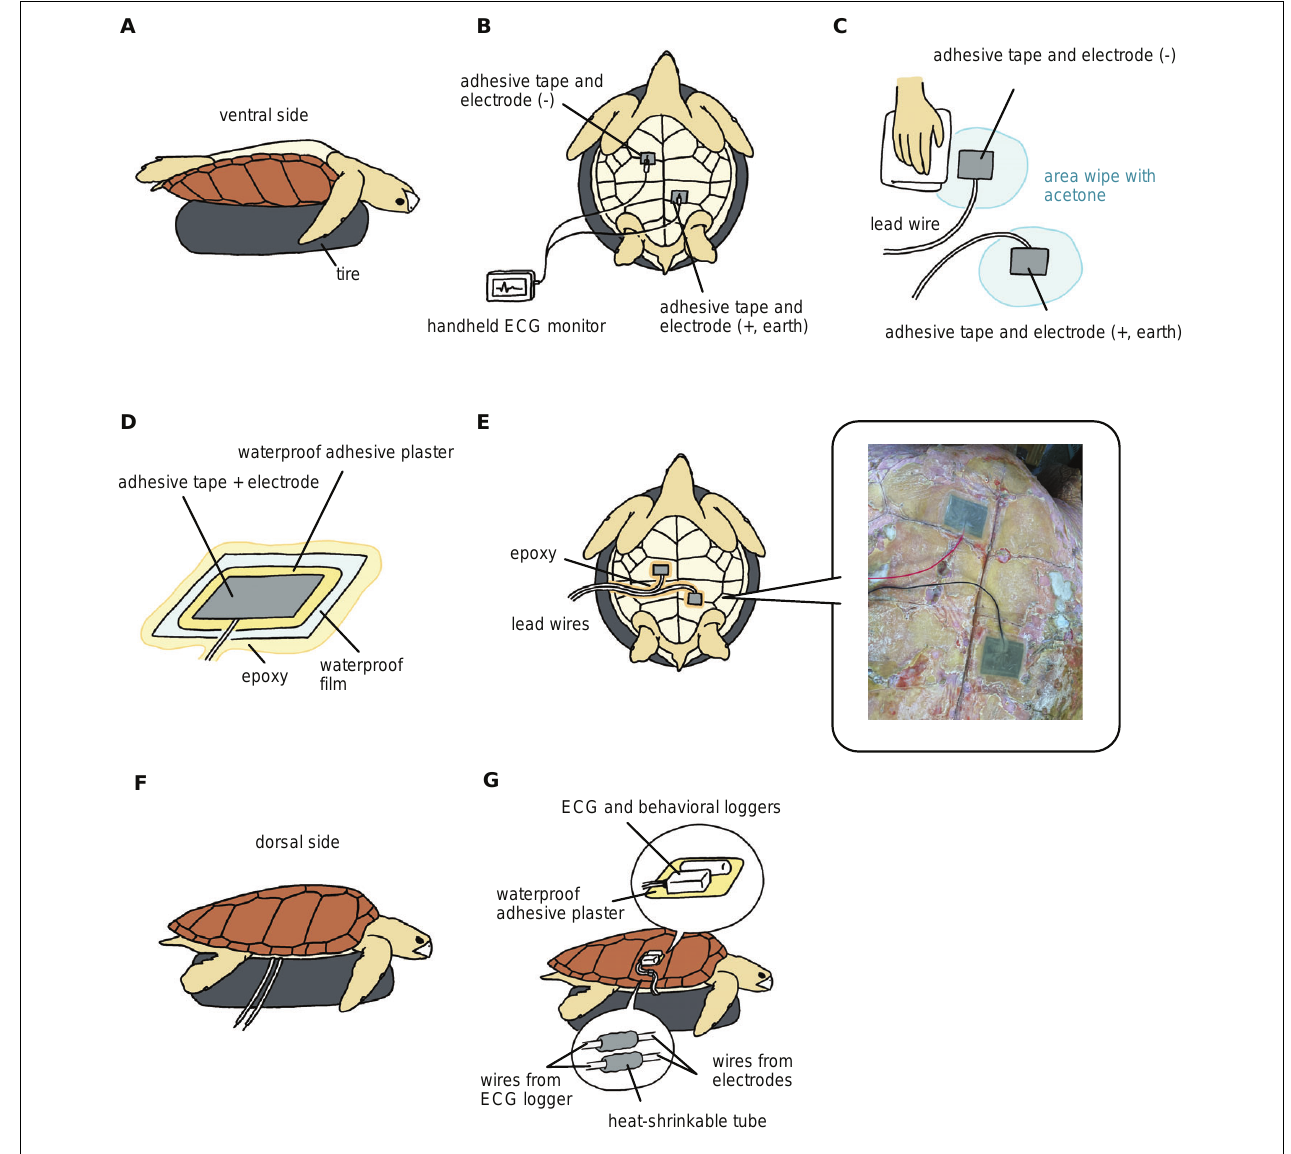
FIGURE 2 | Step-by-step instruction of attachment the electrodes on the ventral side and the loggers on the dorsal side. (A) Place a tire underneath the turtles to hold them as upside down. (B) Two electrodes attached close to heart, and check ECG signals. (C) The plastron around the electrodes was wiped with acetone to avoid wetness. (D) Insulate the outside of the electrode with waterproof adhesive plasters and waterproof films. (E) Seal the edges of the waterproof film and lead wires with epoxy. (F) Turn over the turtle and placed on the tire. (G) Seal joint parts of lead wires with a heat-shrinkable tube. The loggers were fixed onto a waterproof adhesive plaster using an instant adhesive and then attached to the